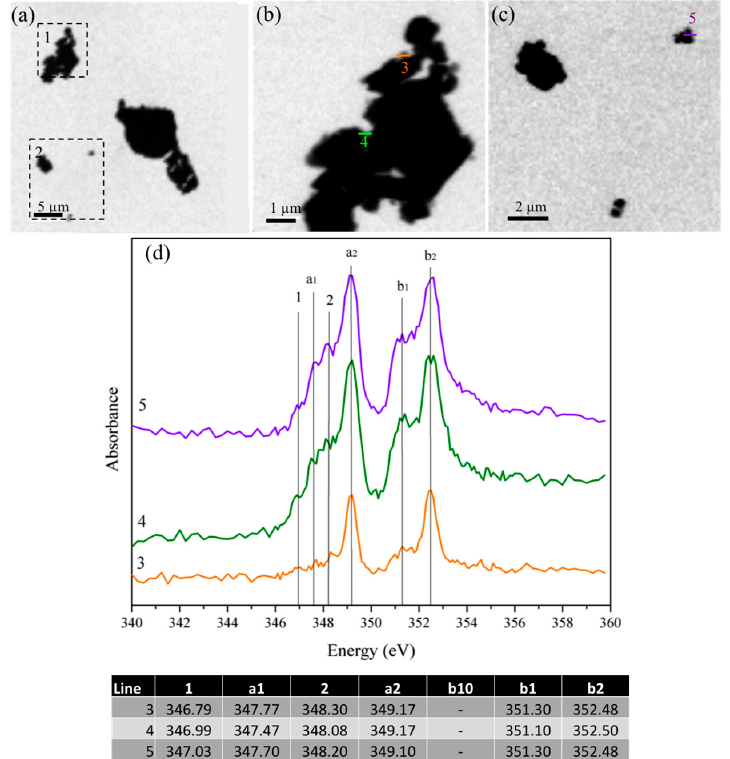
Figure 3. Image taken at the calcium L II,III edge of the cubic C 3 A sample: ( a ) deneral overview of the particles; ( b ) detail of area 1 underlined in ( a ); ( c ) detail of area 2 underlined in ( a ); and ( d ) NEXAFS spectra at the Ca L II,III edge for line scans 3–5. The table shows the peak positions in the Ca L II-II edge of the NEXAFS spectra shown in ( d ).